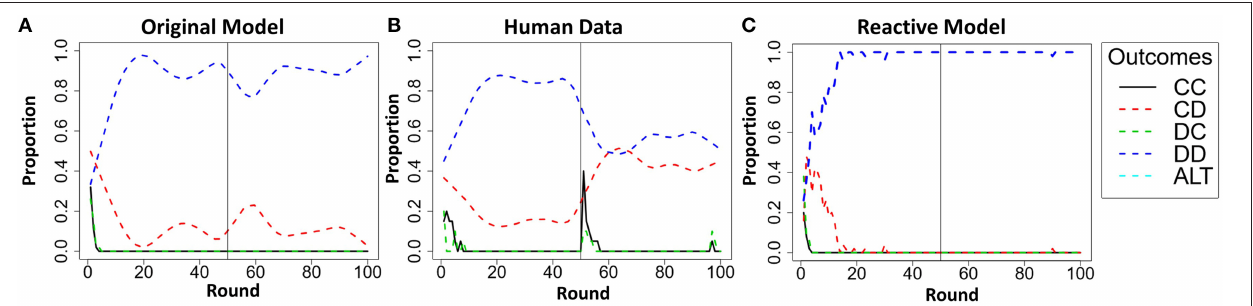
FIGURE 10 | Results of the original model predictions (A), human data (B), and reactive model (C) in the Pavlov-Tit-for-Tat Low Trustworthiness condition when playing Prisoner’s dilemma (PD) and then Chicken Game (CG). Each graph shows the round-by-round proportion of each of the five possible outcomes, mutual cooperation (CC), unilateral cooperation (CD), unilateral defection (DC), mutual defection (DD), and asymmetric alternation (ALT). All of the overall round-by-round proportions were smoothed by using the loess function in R (smoothing parameter of 0.2), to remove some of the round-by-round variability.